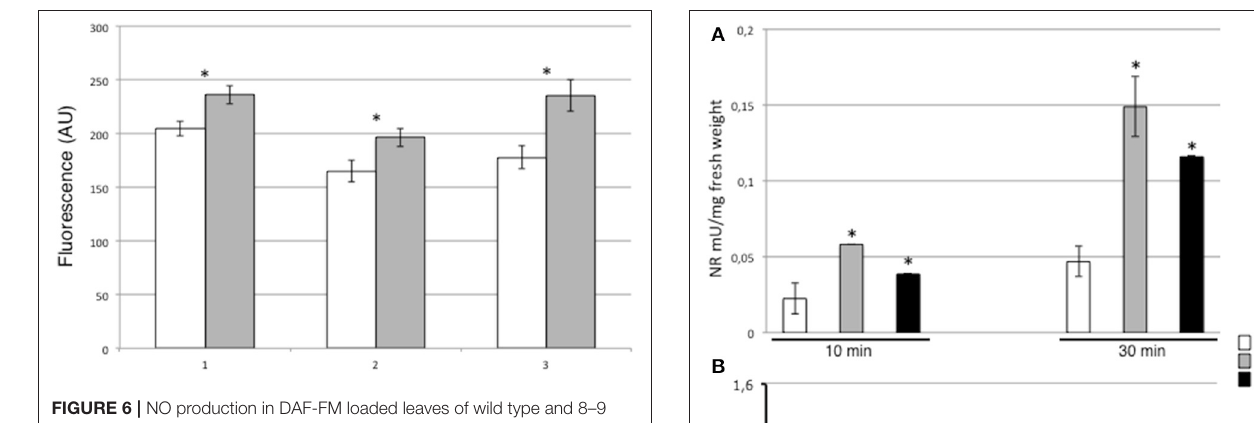
with NAGK (Sugiyama et al., 2004; Chen et al., 2006;